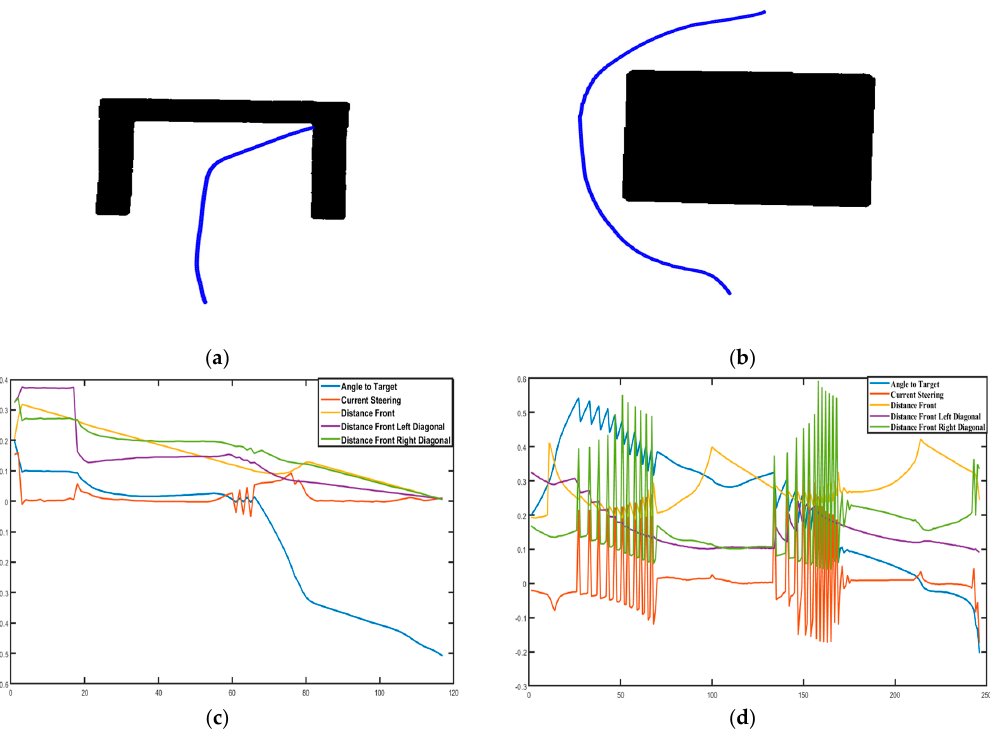
Figure 10. Test results for the first scenario (Figure 8) (collision detection ( a ), convex hull applied image and safe path generated from the image ( b ), the variable obtained from Figure 9a path generation when the robot goes to the goal ( c ), the variable obtained from Figure 9b path generation when the robot goes to the goal ( d )).